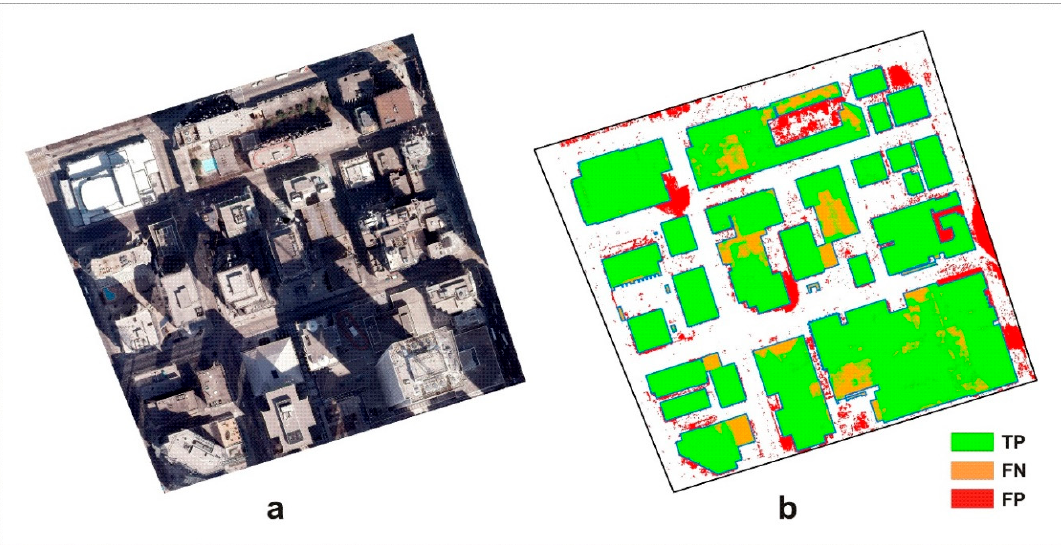
Figure 10. The orthophoto of the study area in Toronto ( a ) and the result of building extraction ( b ) of the ISPRS Benchmark Dataset (TP: true positive; FN: false negative; FP: false positive).